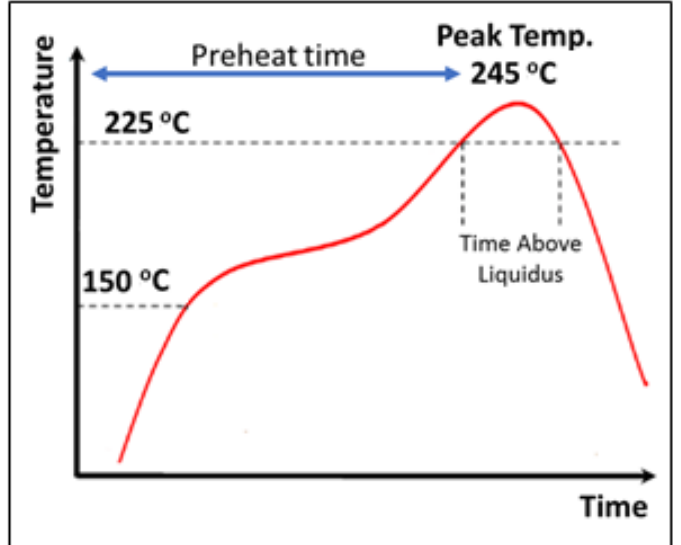
Figure 2. The Reflow profile.